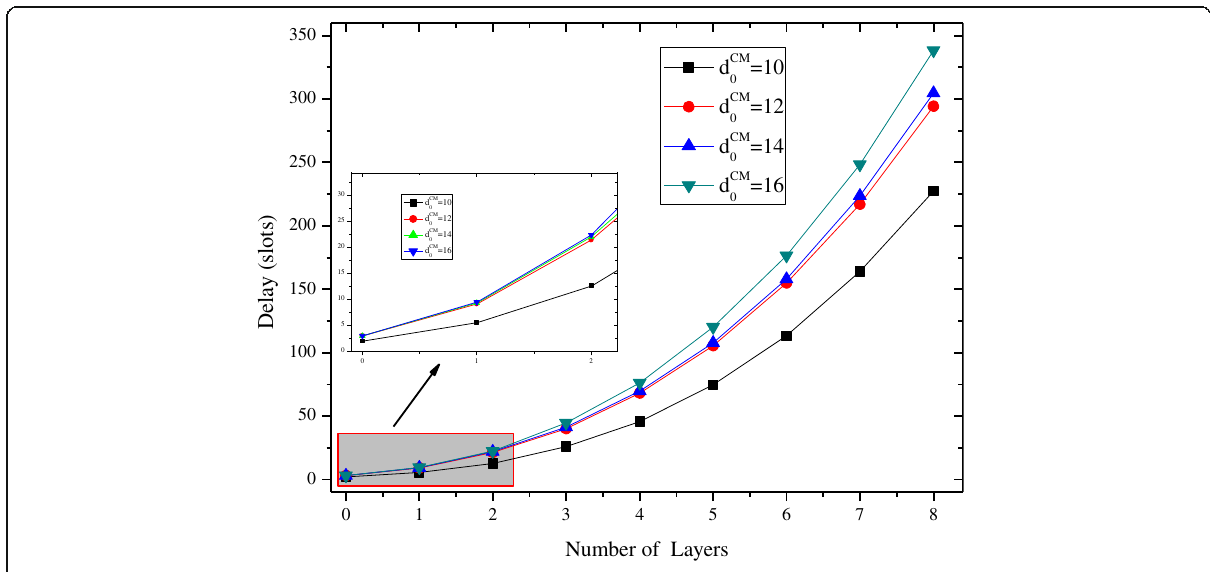
Fig. 9 Delay with different d CM